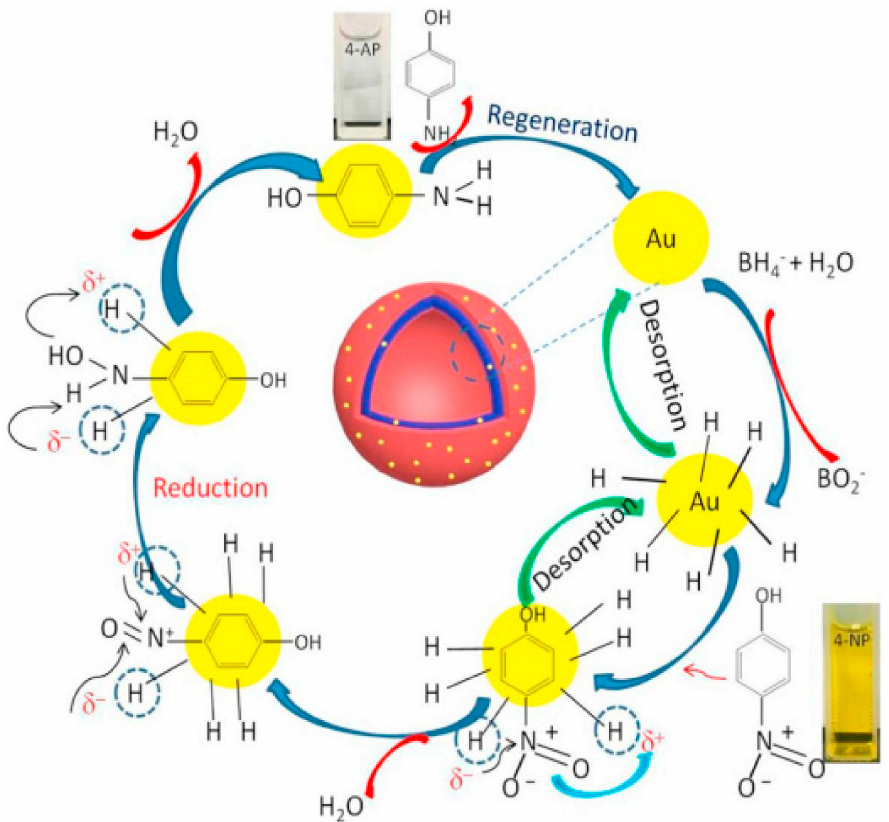
Figure 53. The catalytic mechanism for reduction of 4-NP by Au NPs@vesicles catalyst. Reproduced with permission from Elsevier [446], Copyright 2019, Materials Science & Engineering